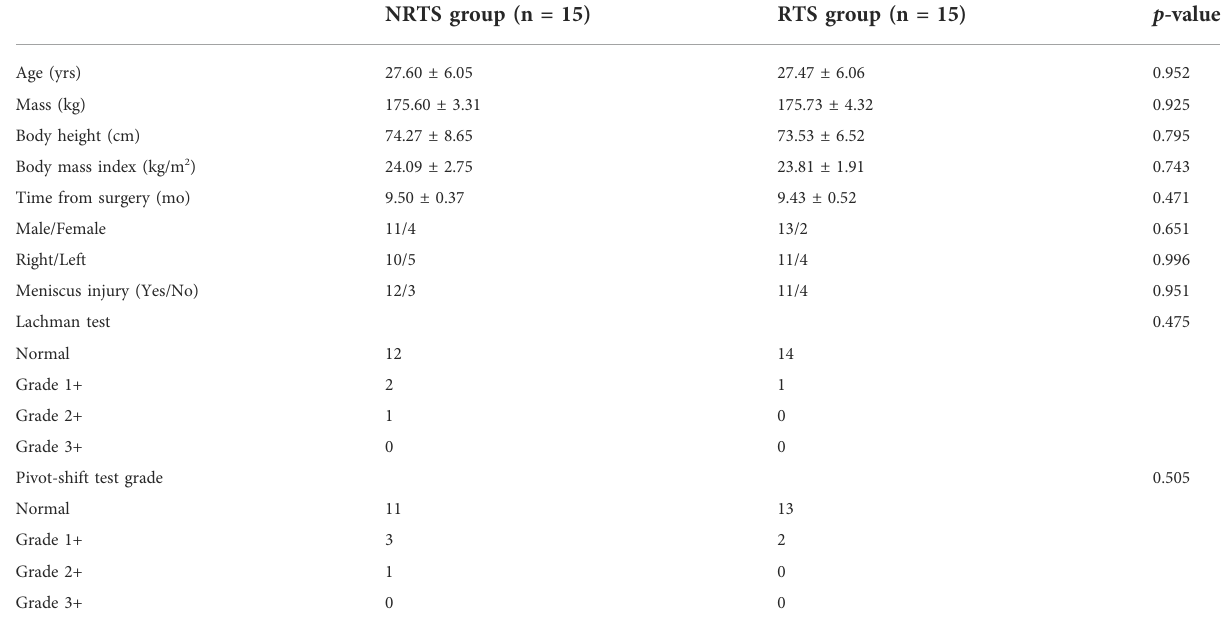
TABLE 1 Patients and clinical